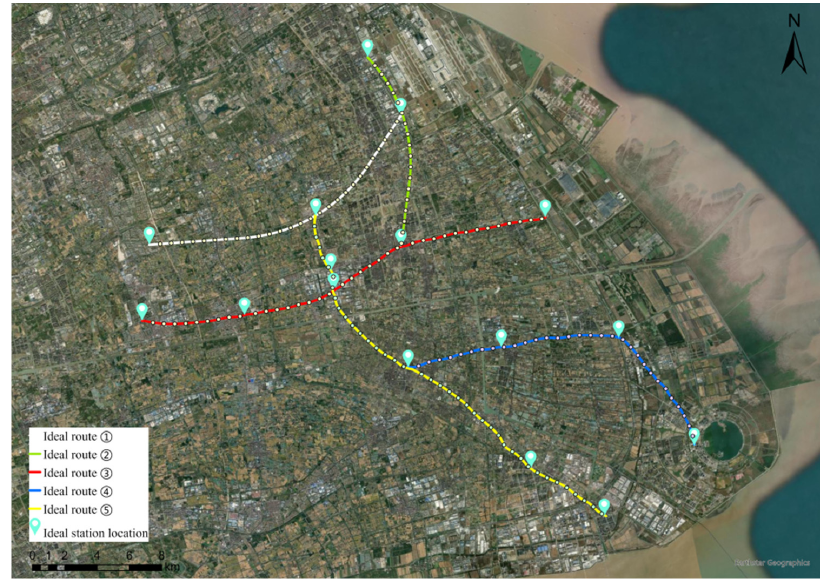
Figure 18. The ideal station location and five routes of the expected plan.